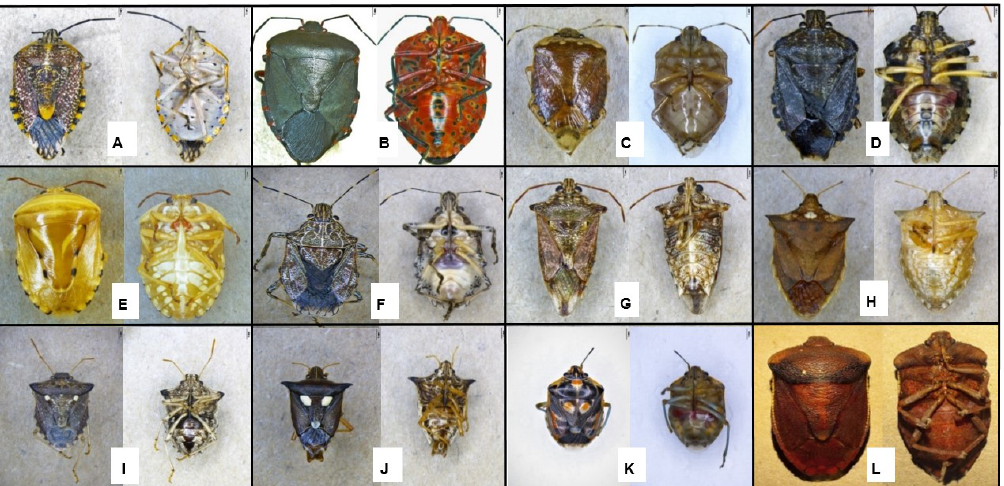
Figure 3. Stink bug species found in low proportions during the 2019–2020 season in all three grow- ing regions. ( A ). Agonoscelis versicoloratus ( B ). Caura rufiventris ( C ). Antestia sp. ( D ). Coenomorpha nervosa ( E ). Platacantha lutea ( F ). Anolcus campestris . ( G ). Macrorhaphis acuta ( H ). Tripanda signitenens ( I ). Carbula recurva ( J ). Aspavia albidomaculata ( K ). Antestiopsis thunbergii ( L ). Basicryptus costalis .